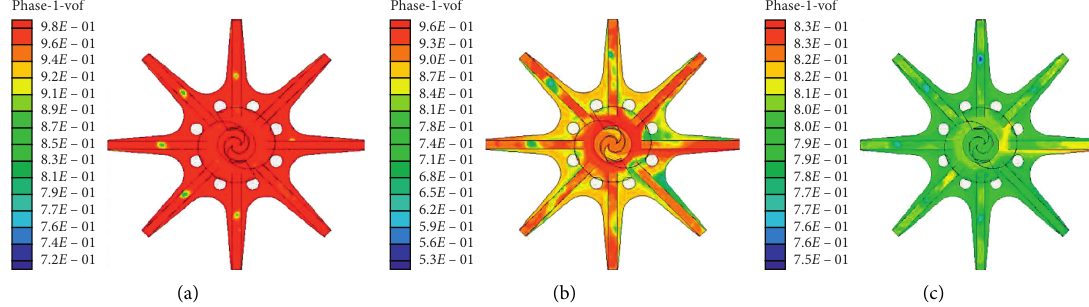
Figure 15: Liquid phase distribution under the different gas-phase concentrations. (a) C